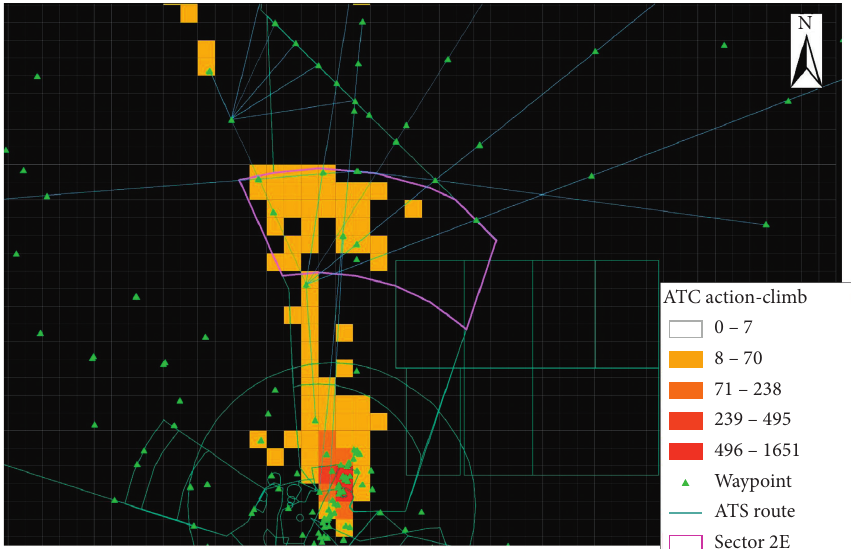
Figure 5: Distribution of ATCO action-climb.